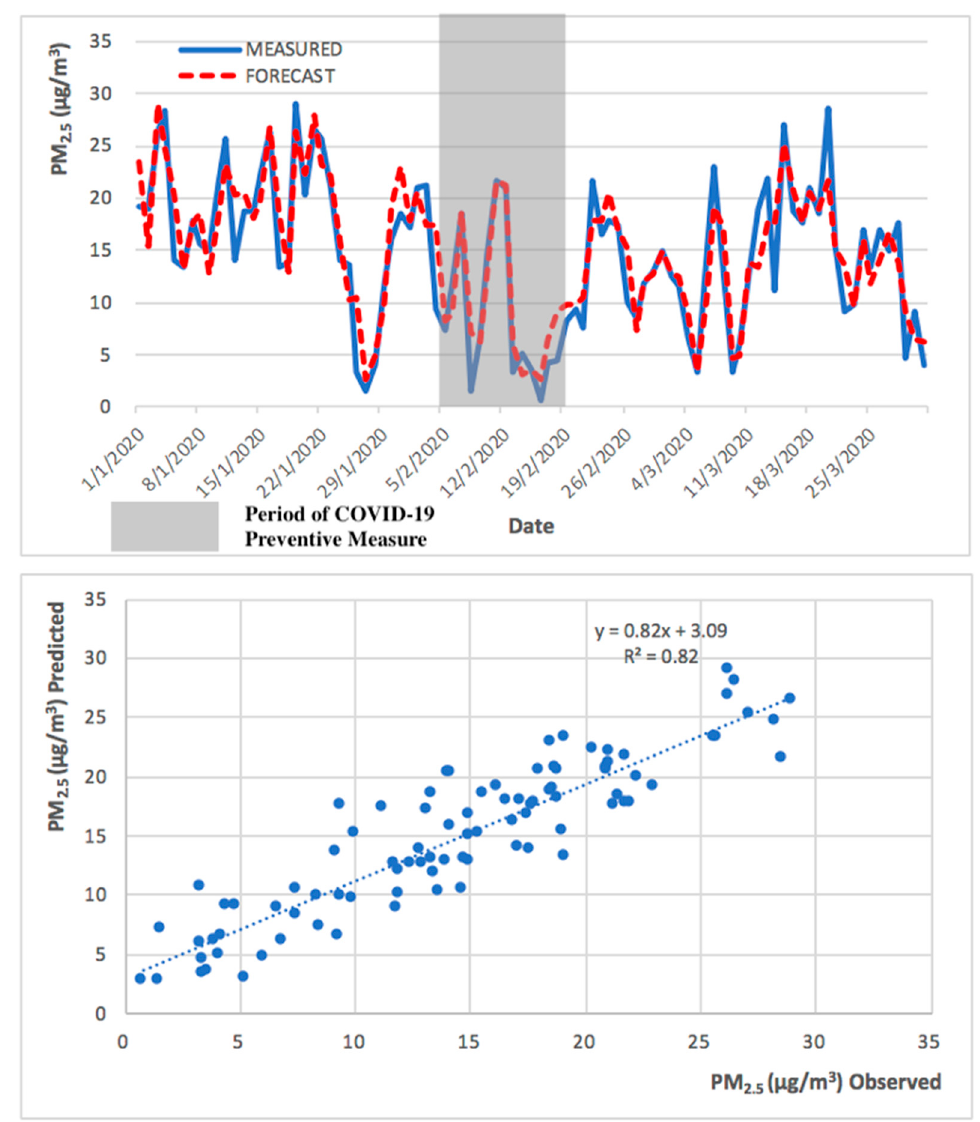
Figure 9. Observed and predicted PM 2.5 concentrations for Taipa Ambient during preventive measures of COVID-19 pandemic (from January to March 2020).